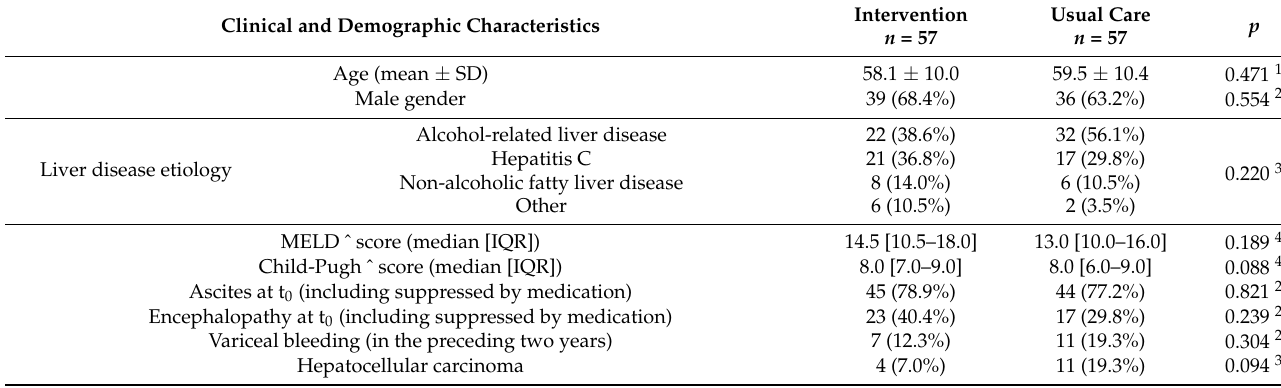
Table 1. Clinical and demographic characteristics of study